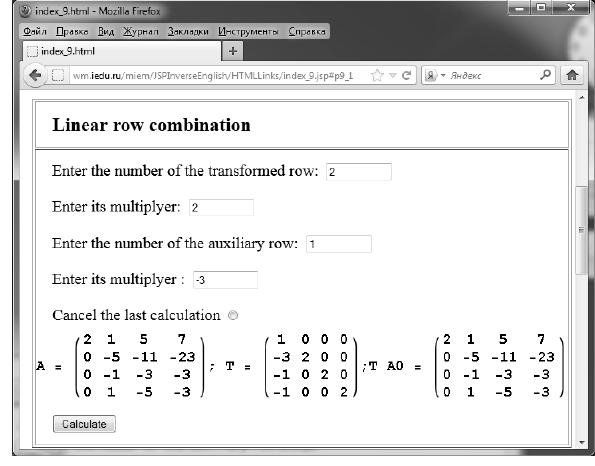
Figure 5. Results of the intermediate